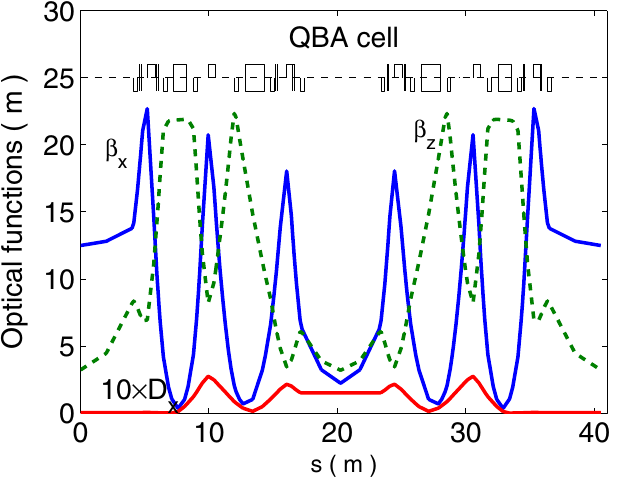
FIG. 8. (Color) The vertical dispersion generated by all quadru- poles with a uniform randomly distributed tilt angle (cid:13) 1 mrad before (red solid line) and after (blue dashed line) harmonic correction.